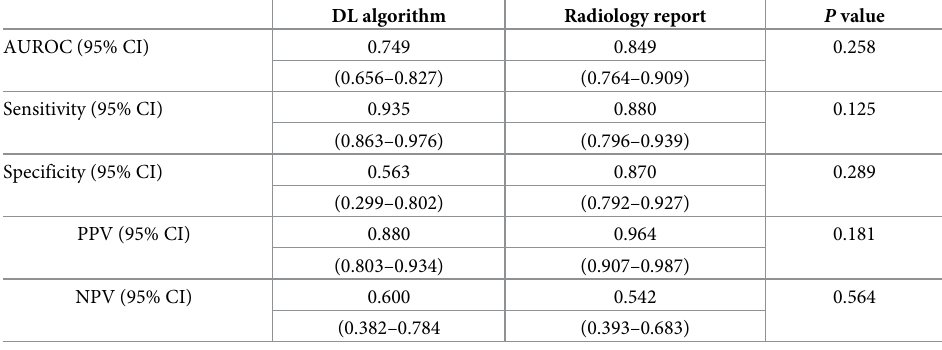
Table 3. Performance of deep learning algorithm for the detection of COVID-19 with and without pneumonia on chest radiography and in computed tomography performed on COVID-19 patients.